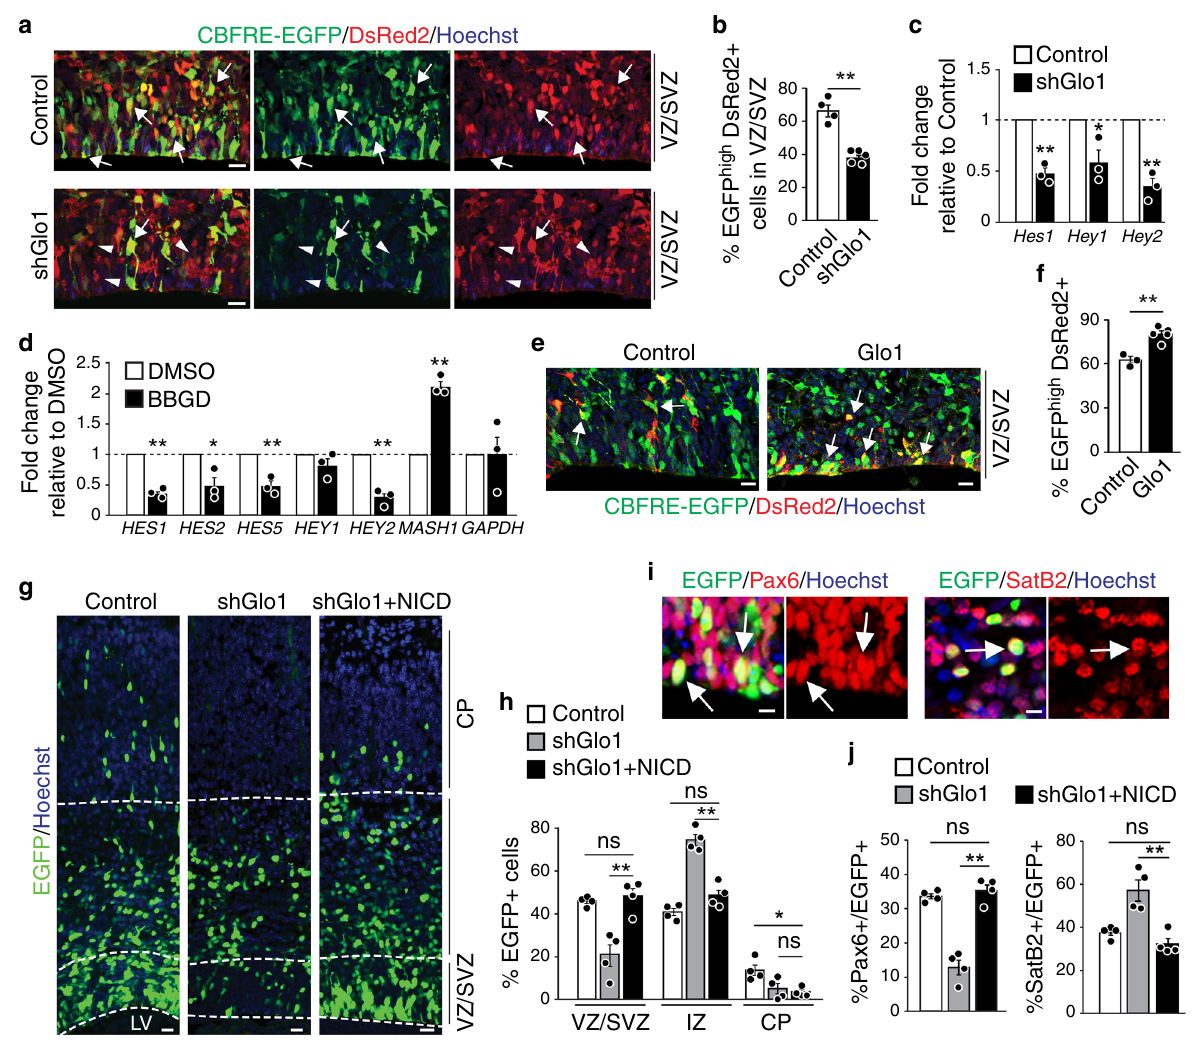
Fig. 2 Methylglyoxal perturbs NPC by suppressing Notch signalling. a , b E13.5 cortices were co-electroporated with CBFRE-EGFP and DsRed2, and control or Glo1 (shGlo1) shRNAs and analyzed two days later. a Images of sections immunostained for EGFP (green) and DsRed2 (red). Arrows denote double-labelled cells, and arrowheads denote cells with reduced Notch signalling. b Quanti fi cation of sections as in a for EGFP + , DsRed2 + cells. n = 4 and 5 embryos each. c qRT-PCR analysis of FACS sorted EGFP + cells from cortices co-electroporated with EGFP and control or Glo1 shRNAs. n = 3 experiments. d qRT-PCR analysis of low passage hNPCs treated with BBGD or DMSO for 48 h. n = 3 experiments. e , f E13.5 cortices were co- electroporated with CBFRE-EGFP and DsRed2 plus empty vector control or a plasmid expressing Glo1 (Glo1) and analyzed two days later. Images ( e ) and quanti fi cation ( f ) of EGFP (green) and DsRed2 (red) double-positive cells. n = 3 and 5 embryos each. g – j A low dose of plasmids (0.5 µ g µ l − 1 ) expressing NICD was co-electroporated with Glo1 shRNA and EGFP into E13.5 cortices. Cortical sections were analyzed three days later. g Images of sections immunostained for EGFP (green). Dotted white lines denote the ventricular surface and boundaries between VZ/SVZ, IZ, and CP. h Quanti fi cation of the relative localization of EGFP + cells. n = 4 embryos each. i Images of the VZ or CP of electroporated sections that were immunostained for EGFP (green) and Pax6 (red, left panels) or Satb2 (red, right panels). Arrows denote double-labelled cells. j Quanti fi cation of the proportion of EGFP + cells that were also positive for Pax6 or Satb2. n = 4 embryos each. LV lateral ventricle, VZ ventricular zone, SVZ subventricular zone, IZ intermediate zone, CP cortical plate. Scale bars, 25 µ m in a , e and g ; 10 µ m in i . Data are presented as mean values± SEM and analyzed using two-tailed, unpaired students t -test